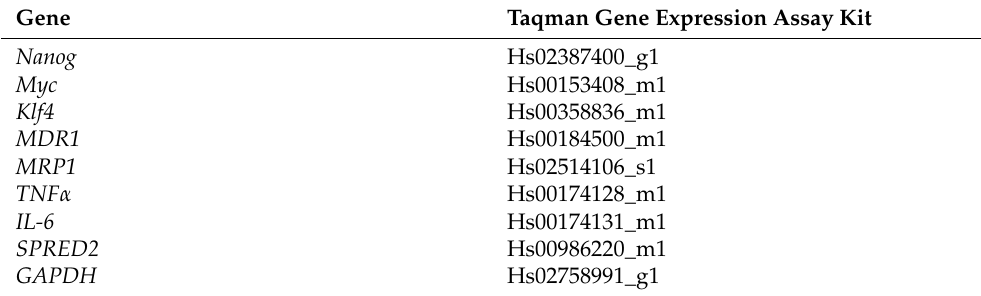
Table 2. Taqman gene expression assays used for RT-qPCR.